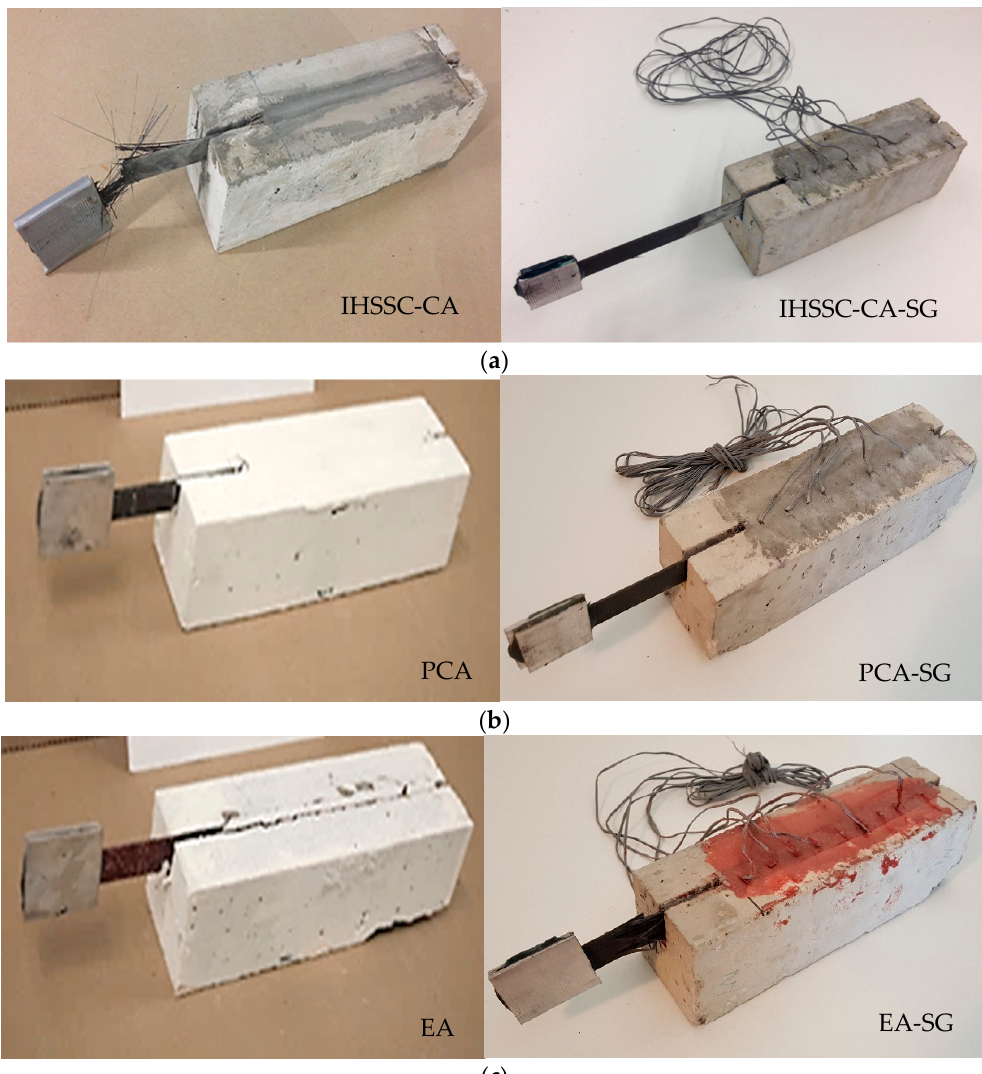
Figure 5. ( a ) IHSSC-CA and IHSSC-CA-SG specimens; ( b ) PCA and PCA-SG specimens; ( c ) EA and EA-SG specimens.